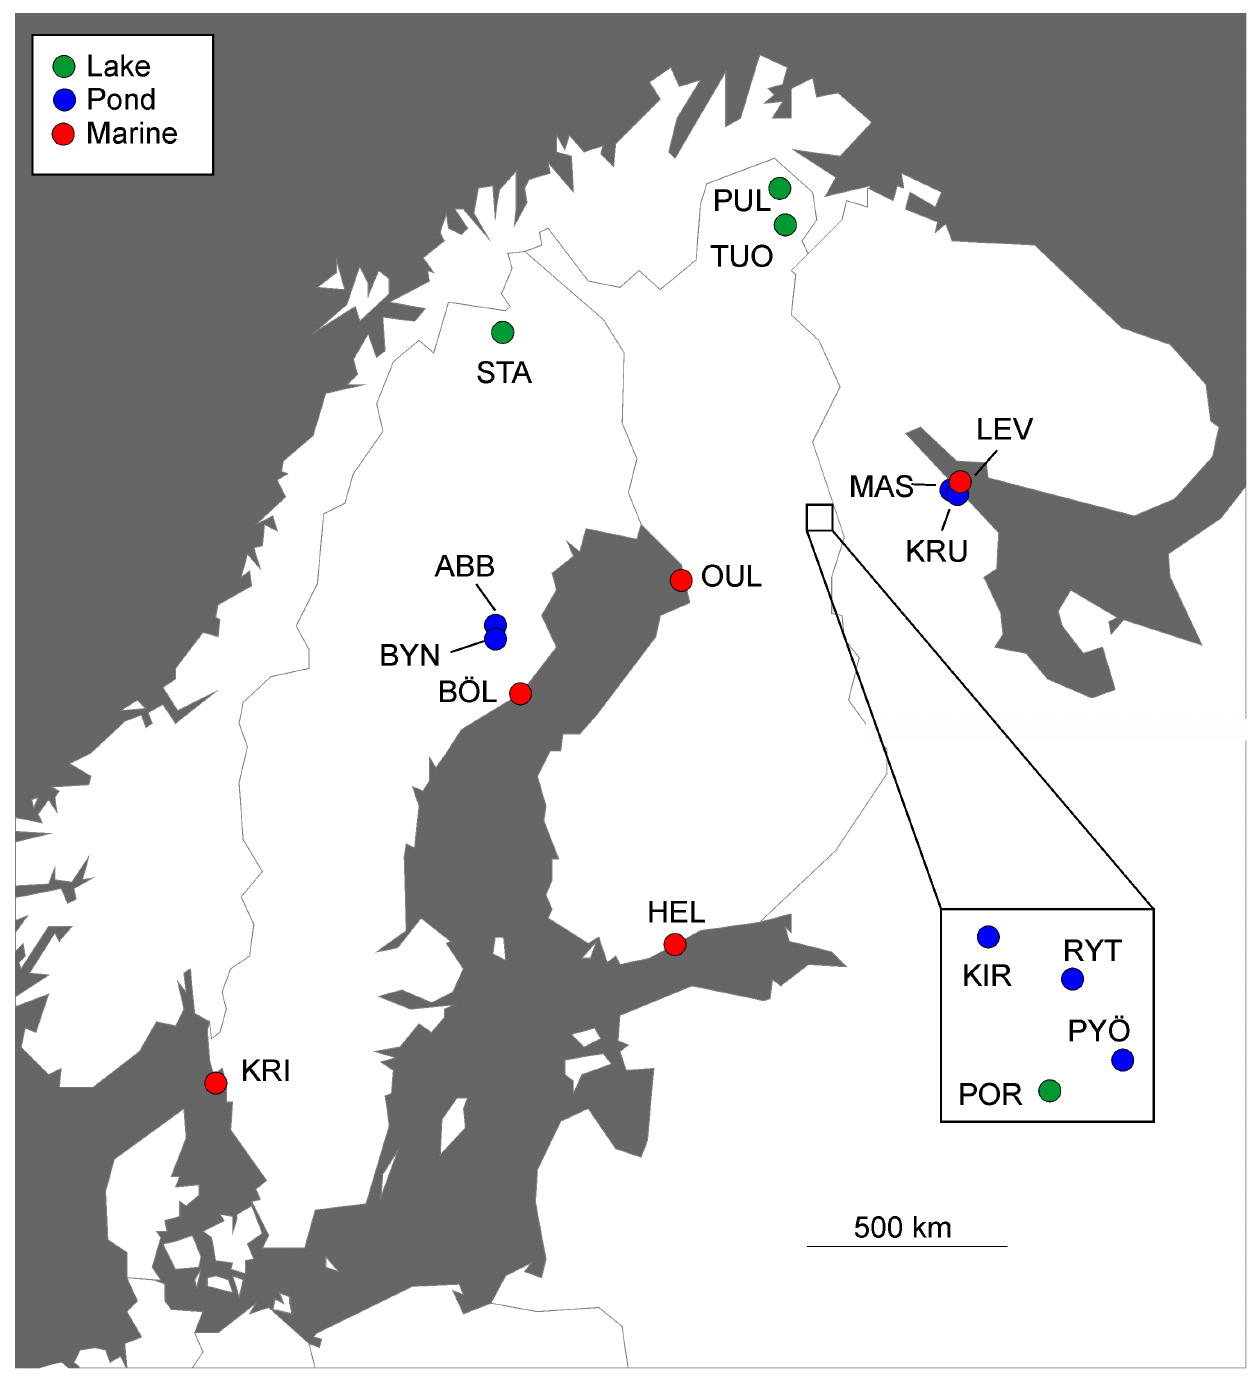
Figure 1. A map showing the 16 sampling locations in Fennoscandia. Green=lakes; blue=ponds; red=marine.